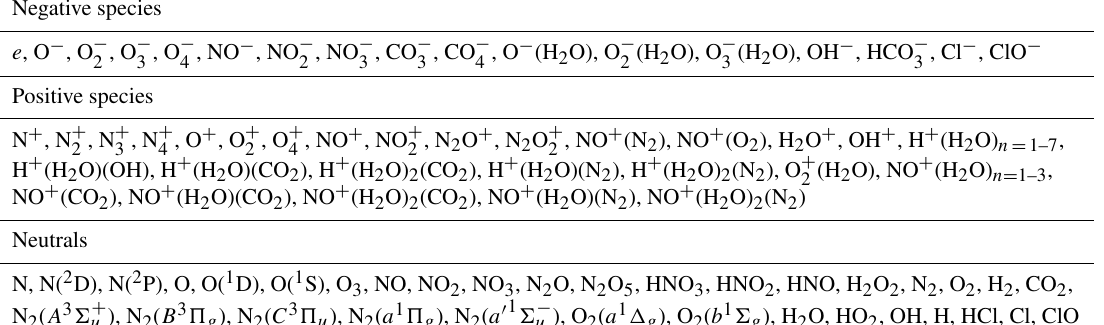
Table 2. Modelled species. The last row shows the molecules additionally included compared to the model of Winkler and Notholt (2015). Negative species